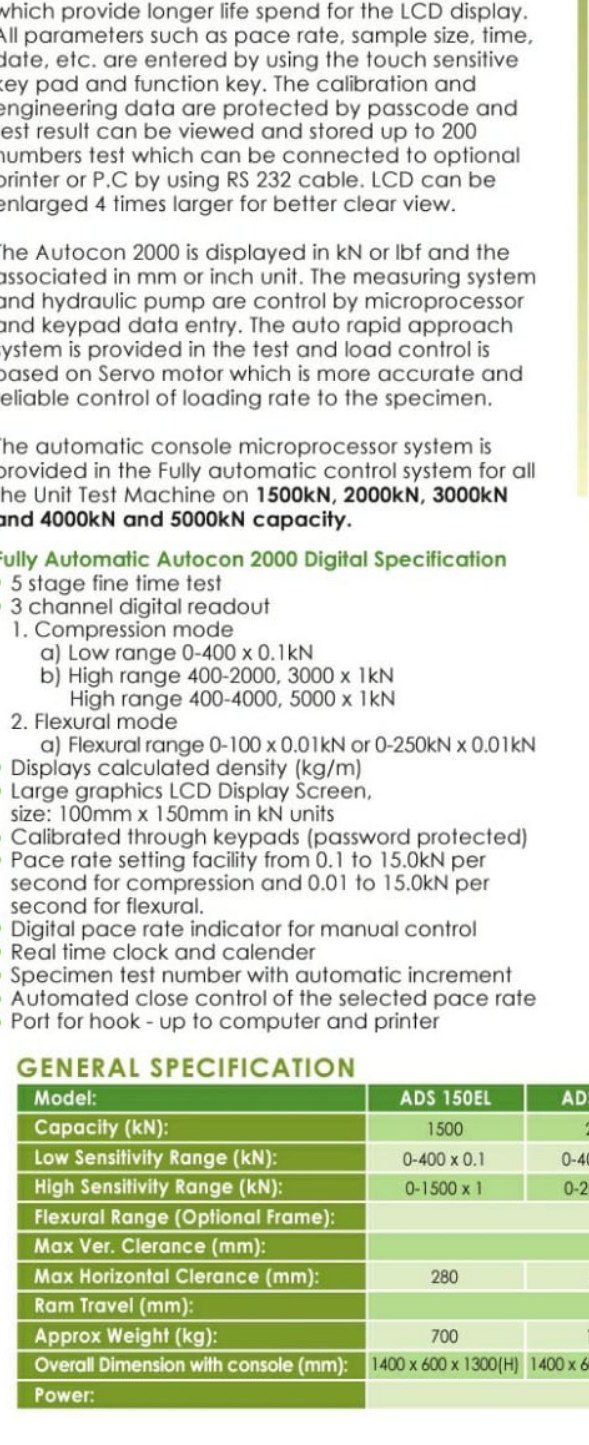
Figure A1. Autocon 2000 Digital Console.